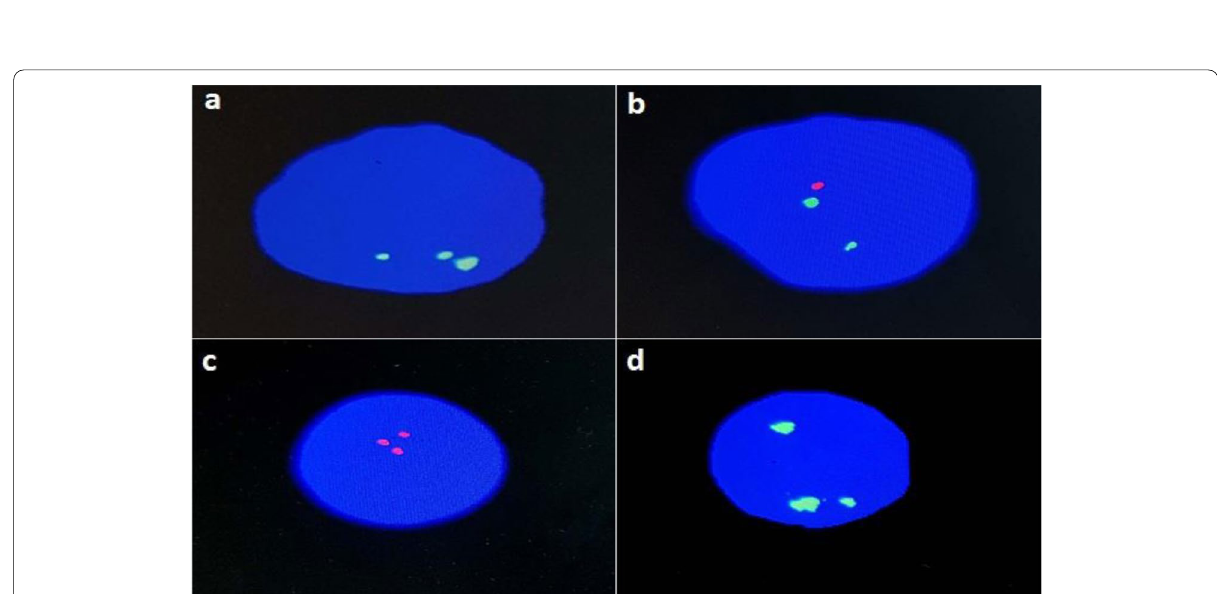
Fig. 4 FISH for the triploidy sample: a using CEP 2 (Metasystem) spectrum green showing three signals indicating the triploidy; b using CEP X,Y probe showing two green signals for the X chromosome and one red signal for the Y chromosome; c using LSI 21 showing three red signals; d using LSI 13 showing three green